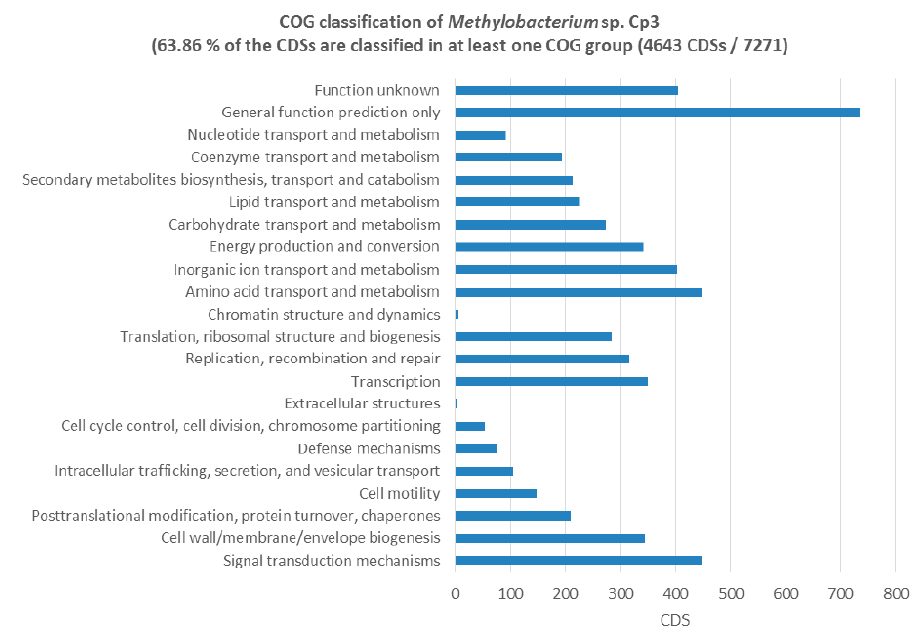
Figure 7. COG classification of the CDS of Methylobacterium sp. Cp3.